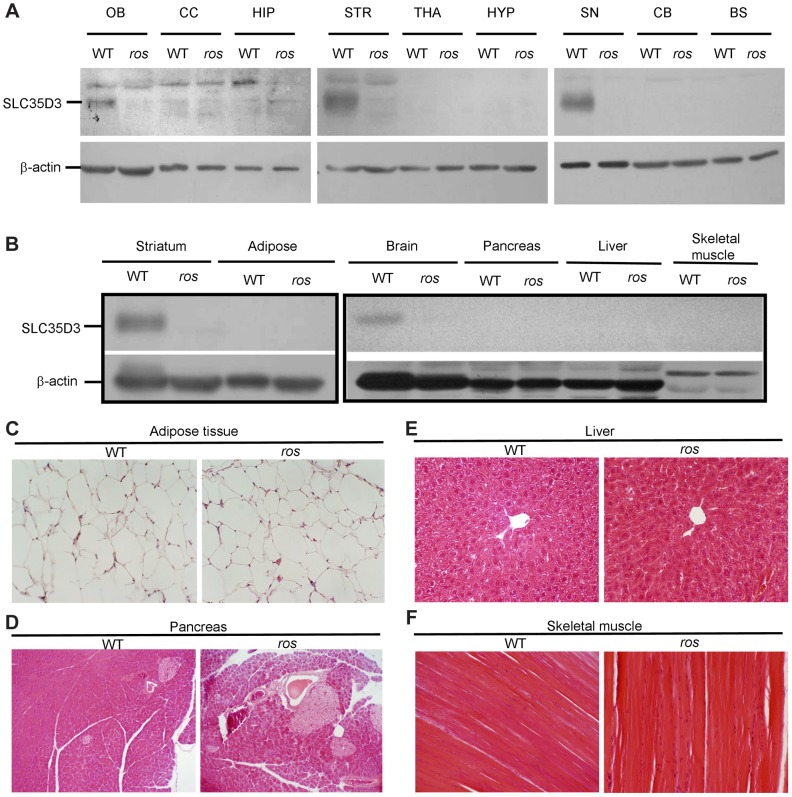
SLC35D3 expression in brain sub-regions and non-neuronal tissues.Mice at 24 weeks of age were used in this study. (A) Immunoblotting of SLC35D3 protein in nine brain sub-regions of wild-type (WT) and ros mice. OB: olfactory bulb, CC: cerebral cortex, HIP: hippocampus, STR: striatum, THA: thalamus, HYP: hypothalamus, SN: substantia nigra, CB: cerebellum, BS: brain stem. (B) Immunoblotting assay showed no expression of SLC35D3 in adipose tissue, pancreas, liver, or skeletal muscle compared with striatum or brain in WT mice. There was no expression of SLC35D3 in any of these tissues in ros mice. β-actin serves as a loading control. (C) The size of adipose from epididymal fat pad of ros mice was normal. (D–F) No apparent fat accumulation was observed in pancreas, liver, or skeletal muscle in ros mice. 200× magnification was applied in the sections with H–E staining.